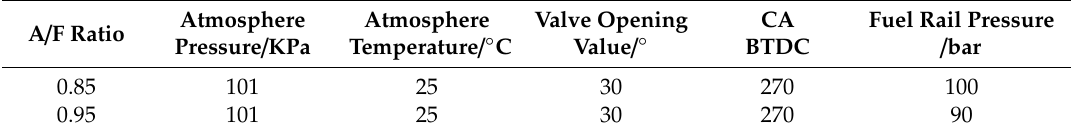
Figure 5. Parameters and setup of Engine at A / F ratio 0.85. Table 1. The parameters and setup of the engine.